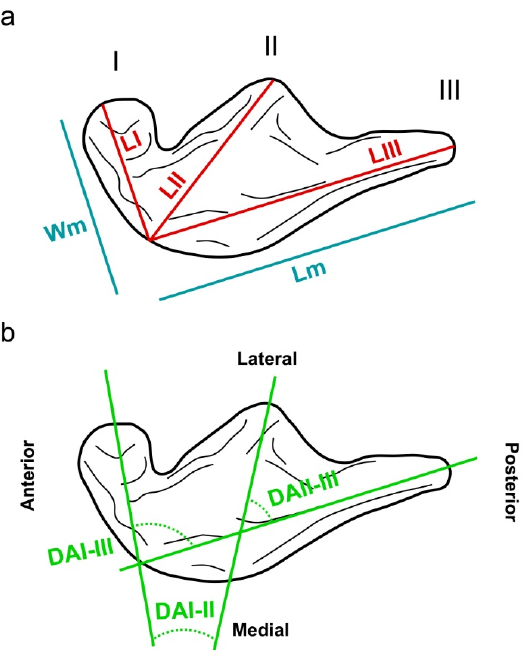
Figure 3. ( a , b ) Orientation of the tracks and measurements used in this work: Lm, length of manus imprint; Wm, width of manus imprint; LI, length of digit imprint I; LII, length of digit imprint II; LIII, length of digit imprint III; DAI–II, divarication angles between digit imprints I–II; DAII–III, divarication angles between digit imprints II–III; DAI–III, divarication angles between digit imprints I–III.